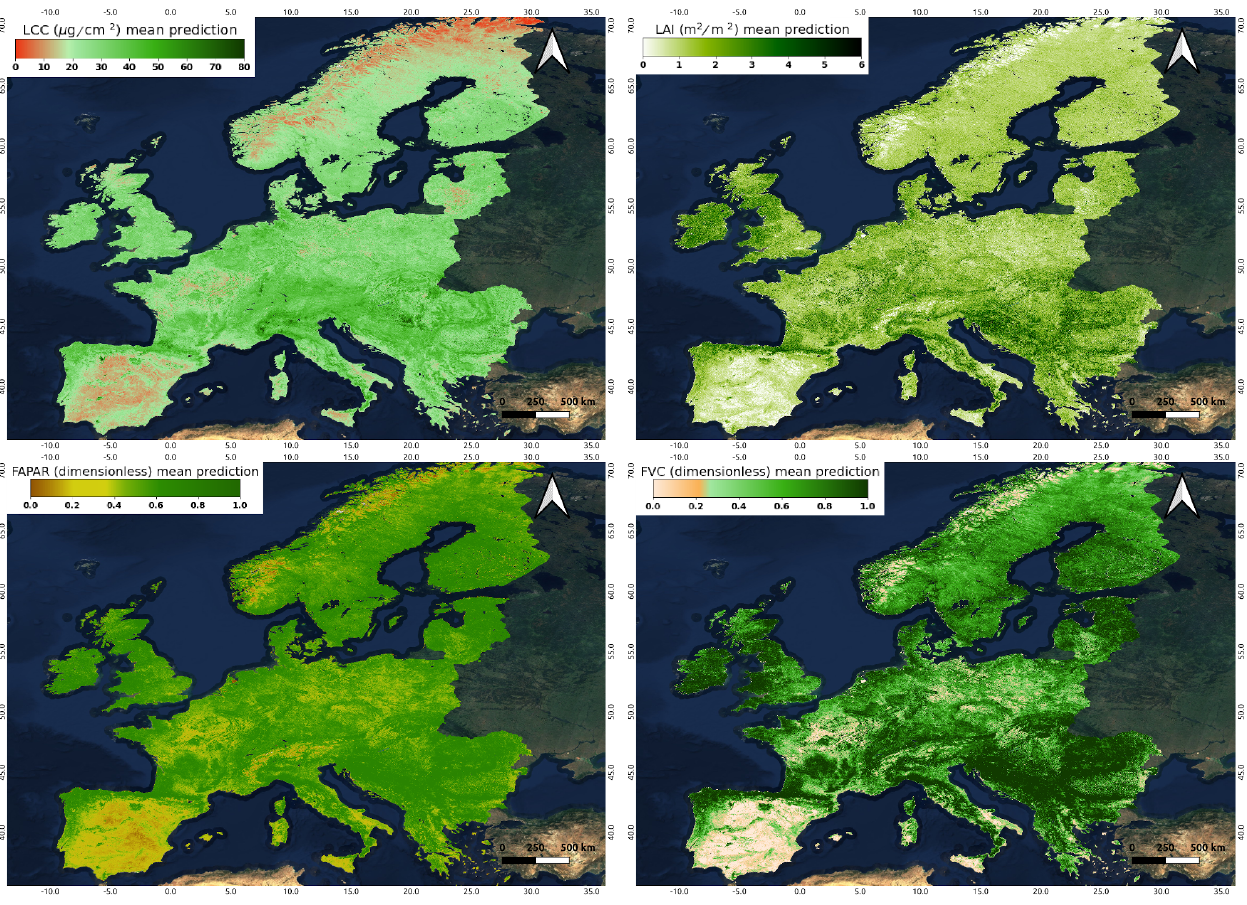
Figure 4. Monthly composite maps (July 2018) of vegetation traits produced by S3-TOA-GPR-1.0 models over Europe: LCC ( top-left ), LAI ( top-right ), FAPAR ( bottom-left ), and FVC ( bottom-right